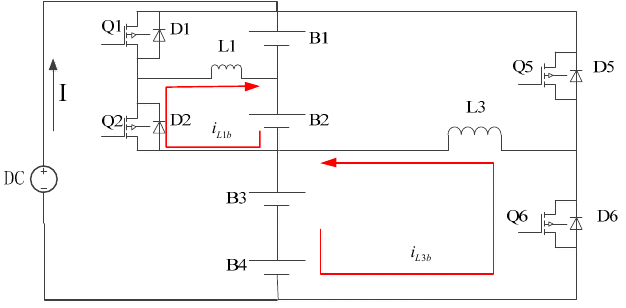
Figure 4. Schematic of the second stage of charge equalization.